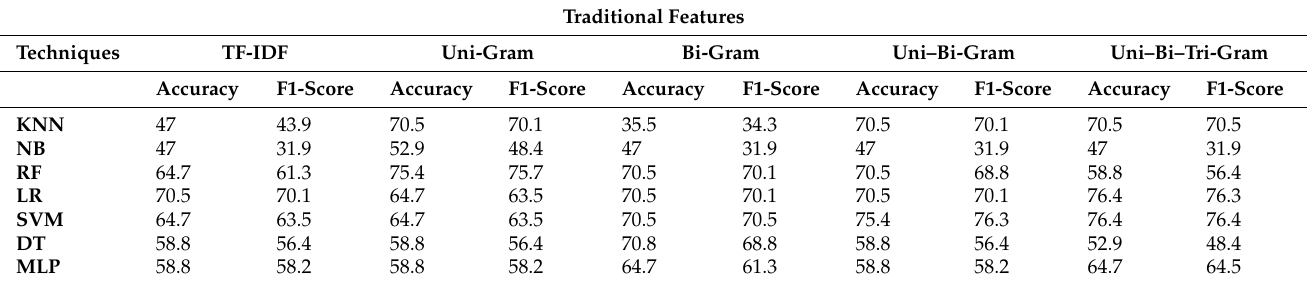
Table 7. Real-time tweets dataset result for ML classifiers with raw labeling.